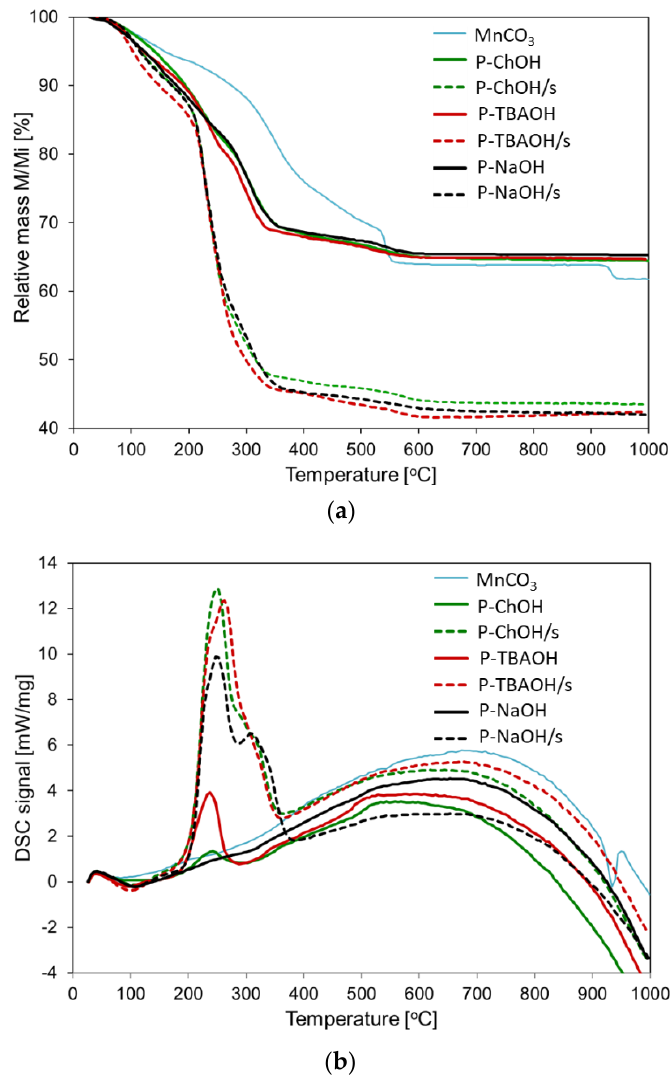
Figure 8. Thermal analysis of synthesized precursors and of the MnCO 3 reference: ( a ) TG profiles; ( b ) DSC